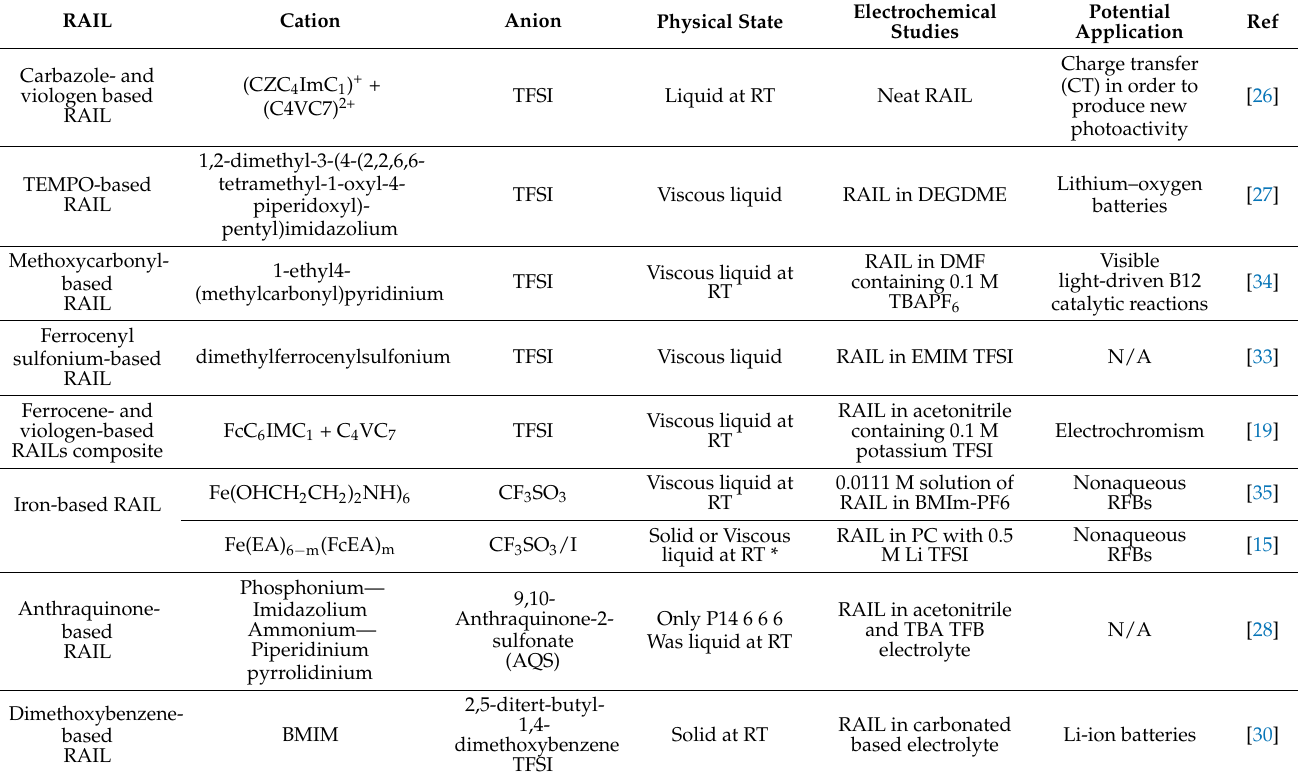
Table 1. Example of selected RAILs, their representative cations and anions, physical state and potential applications. RAIL Cation Anion Physical State Electrochemical